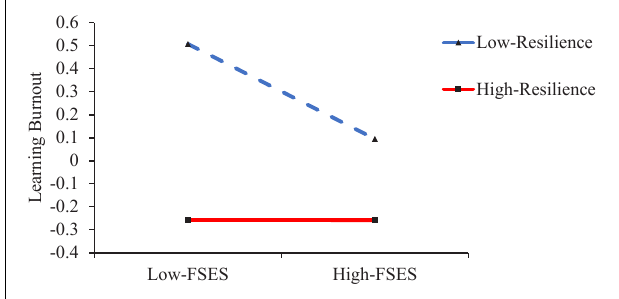
FIGURE 2 | Moderating role of resilience in the relationship between FSES and learning burnout.